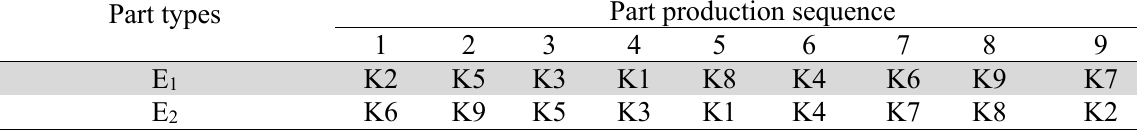
Part – Production center incidence matrix (best route considered with least makespan) Part types Part production